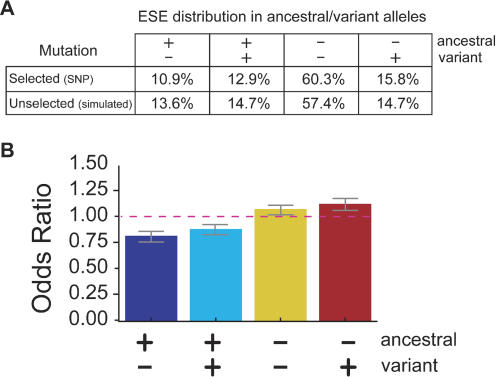
Analysis of the Effects of SNPs and Unselected Mutations on Predicted ESEs(A) The percentages of the four prediction outcomes. ESE disruption (+ −), ESE alteration (+ +), ESE neutrality (− −), and ESE creation (− +) changes are listed for the set of 2,561 validated SNPs (selected) and for the set of 100,000 simulated (unselected) mutations.(B) Synonymous and nonsynonymous mutations were analyzed separately and then compared using the MH test for homogeneity. All outcomes passed the MH test for homogeneity (H0:Outcomesynon ≈ Outcomenonsynon; p < 0.05) and could, therefore, be combined into a summary OR (weighted combination of the ORs measured in the synonymous and nonsynonymous sets). The height of each bar can be interpreted as the odds that the listed outcome will occur in the evolutionarily selected set of mutations (SNPs) relative to the odds that the same outcome will occur in the unselected (simulated mutation) set. Error bars extend one standard deviation on either side of the calculated value.